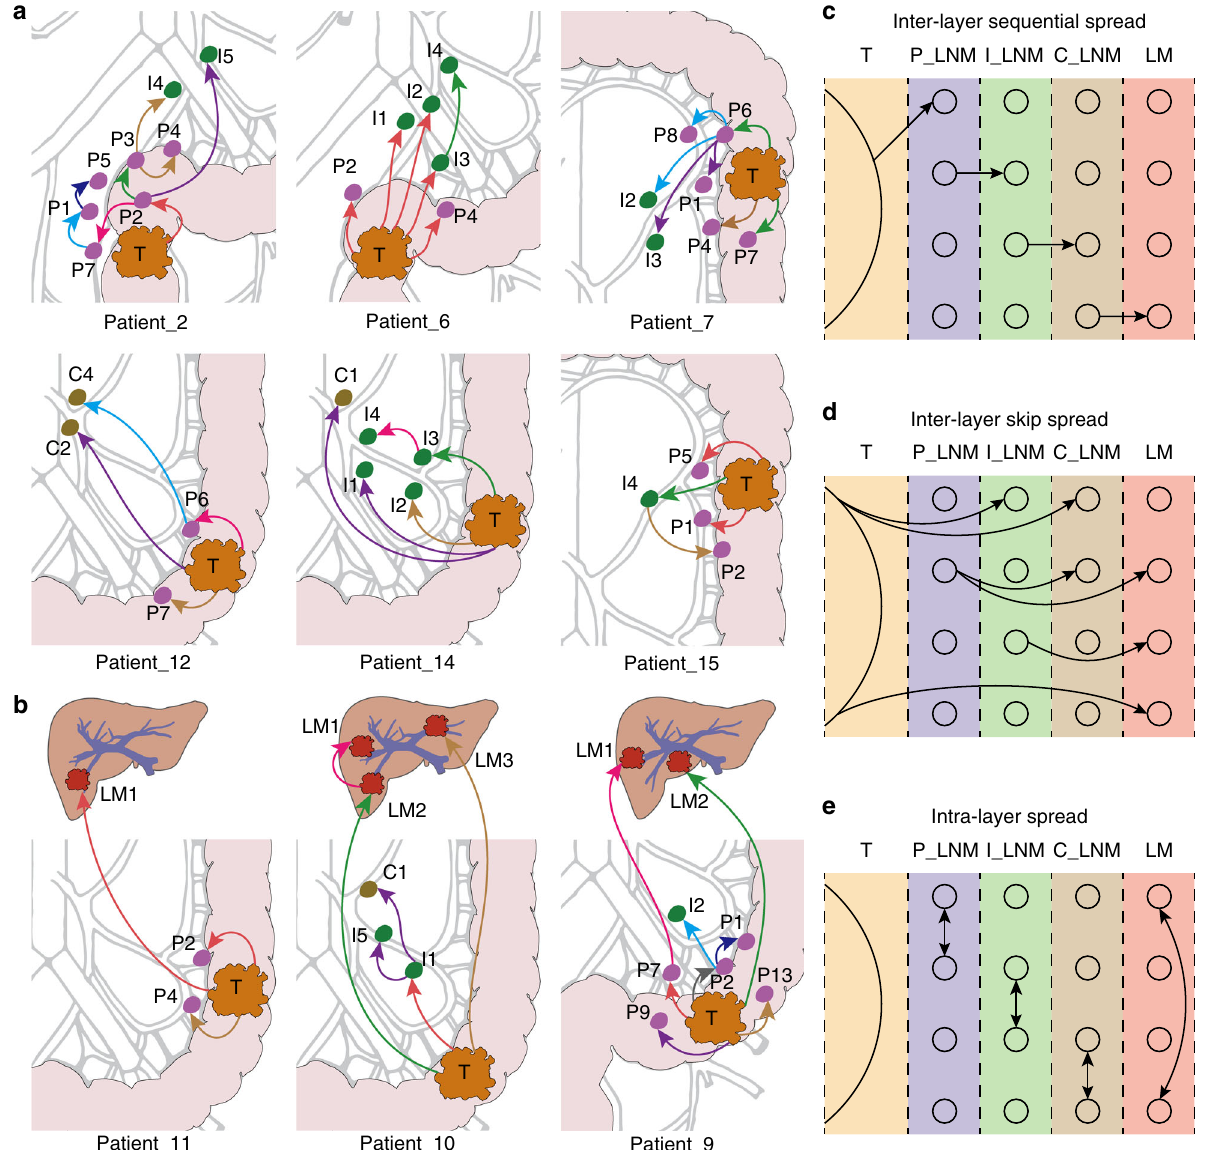
Fig. 5 Parsimonious metastatic maps and three modes of metastasis in CRC. a , b Parsimonious metastatic routes for nine patients. Metastatic routes between lesions are denoted by arrows and colored according to the smallest involved subclone (see Fig. 4). For instance, in Patient_2, P2 is seeded by the red subclone in the primary tumor, thus this route is labeled in red. P3 was then seeded by the red and green subclones from P2, so this route is labeled in green, since the green subclone was smaller. Three metastatic modes were extracted from 61 metastatic events: c inter-layer sequential spread, d inter- layer skip spread, and e intra-layer spread. The metastatic network is dissected into fi ve layers, spanning from T to P, I, C, and LM. The arrows indicate metastatic